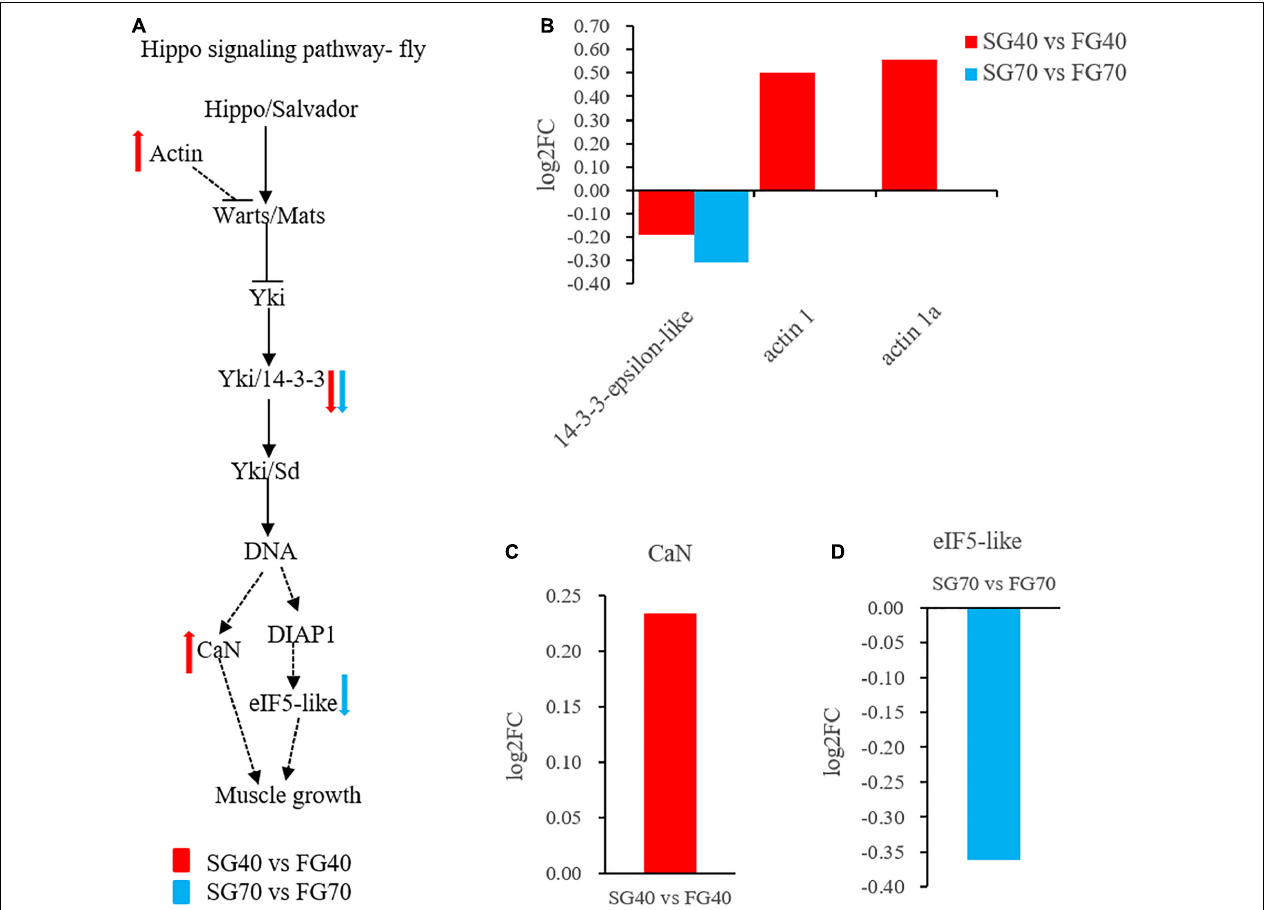
FIGURE 5 | The Hippo signaling pathway regulates the growth of M. japonicus . (A) Hippo signaling pathway network regulation diagram; (B) DEPs expression in Hippo signaling pathway; (C) DEP expression in Wnt signaling pathway; and (D) DEP expression in